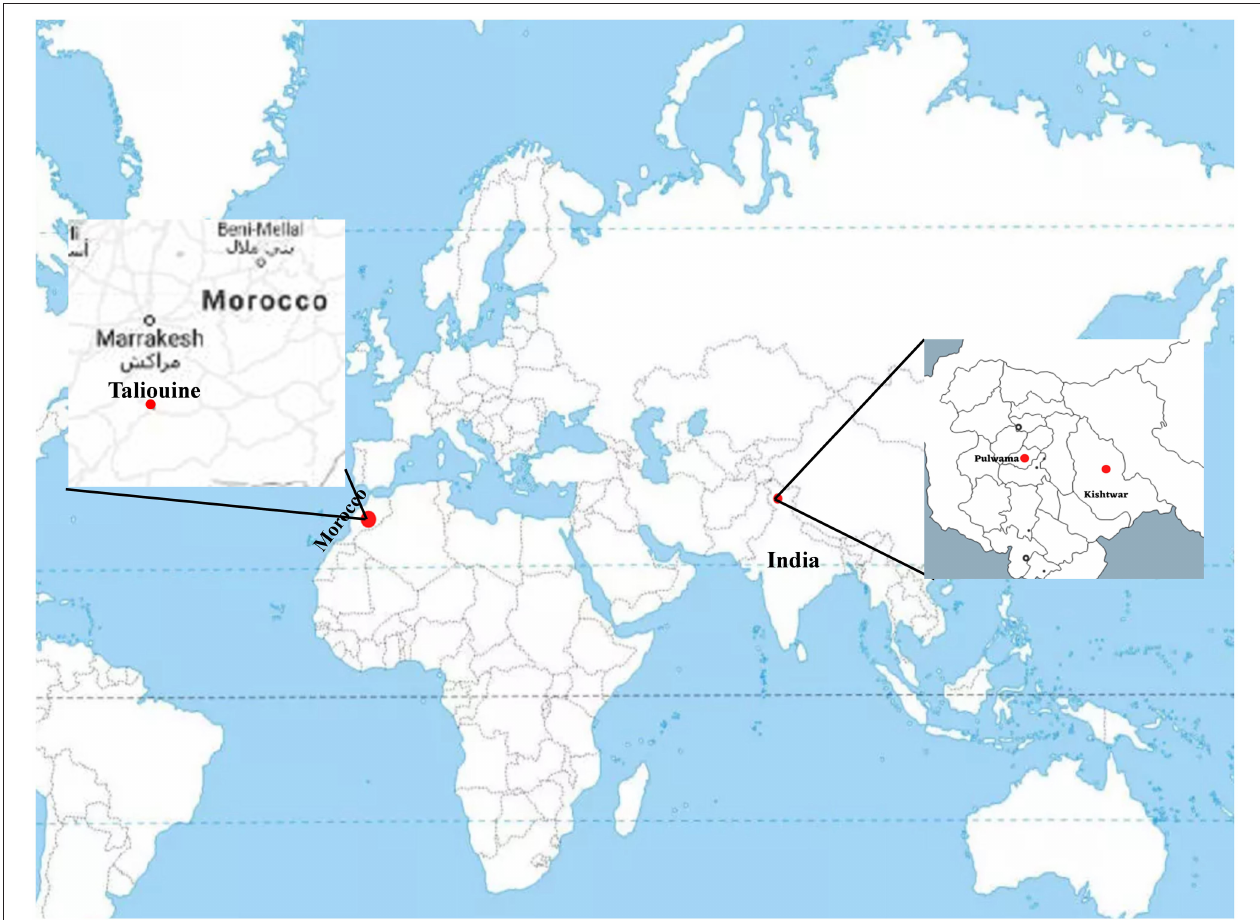
FIGURE 1 | Geographical location of sample collection sites on world map. Kishtwar (33 ◦ 19 ′ 12.00“ N 75 ◦ 46 ′ 12.00 ′′ E), Kashmir (34 ◦ 1 ′ 30 ′′ N 74 ◦ .5 ′ 80 ′′ E), and Morocco (Taliouine, 30 ◦ 31 ′ 58.00 ′′ N 7 ◦ 55 ′ 32.00 ′′ W). TABLE 1 | The temperature and humidity of the three geographical regions: Kishtwar (during different years), Kishtwar-L 17, Kashmir, and Morocco. S. No Conditions Kishtwar Kishtwar-L 17